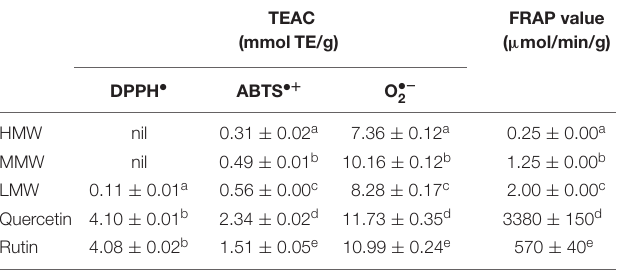
TABLE 3 | Antioxidant activities of Sephadex R (cid:13) G-50 fractions from L. rhinocerus TM02 sclerotial cold-water extract.